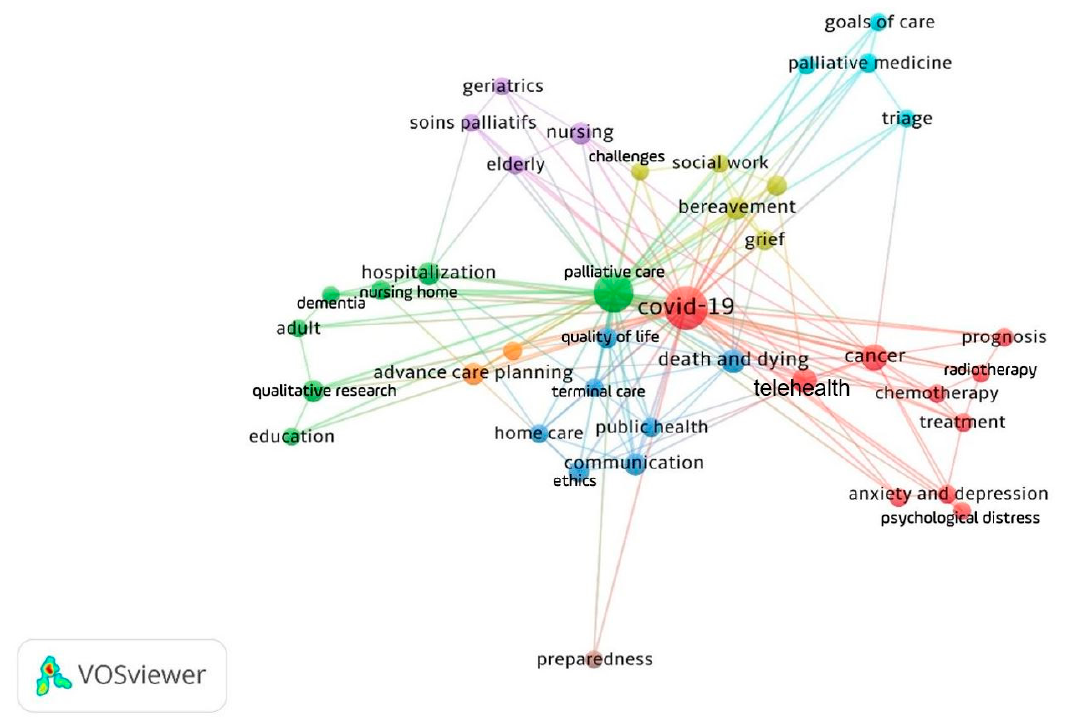
Figure 4. Network visualization map of most frequent author keywords created using VOSviewer. The colors in the map show seven clusters representing seven research themes. Nodes with similar colours represent a cluster of related terms. The figure was created using VOSviewer. Table 4. Most frequently used study keywords in PC-related COVID-19 research.